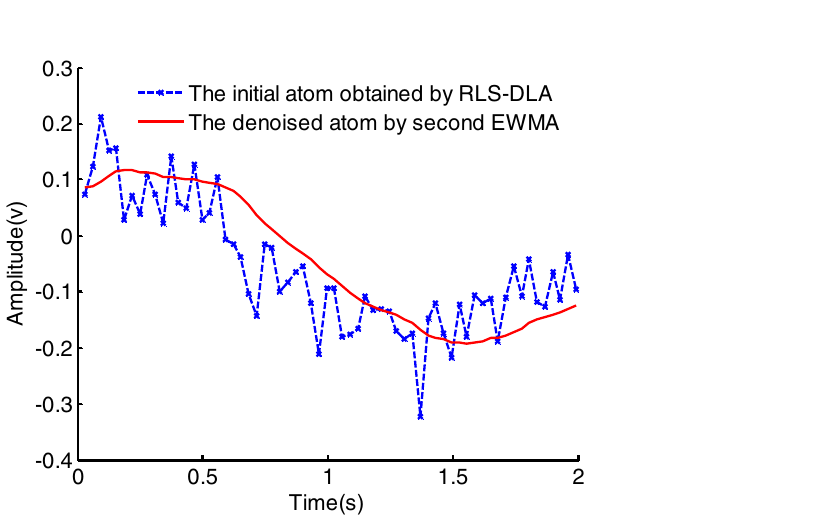
Figure 6. Atom in learned